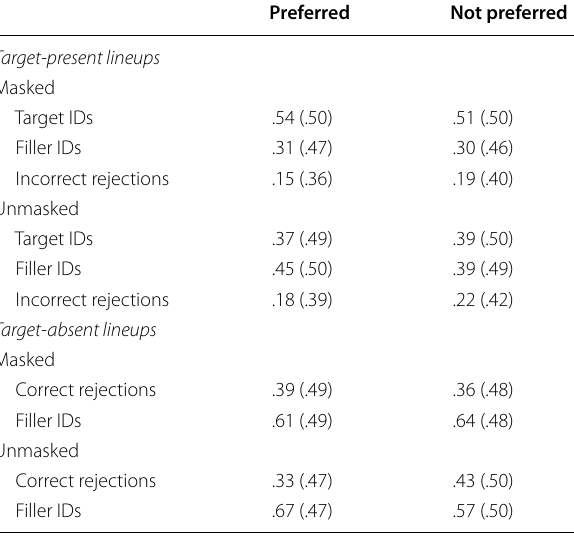
Table 5 Identification proportions as a function of lineup type and preferences in Experiment